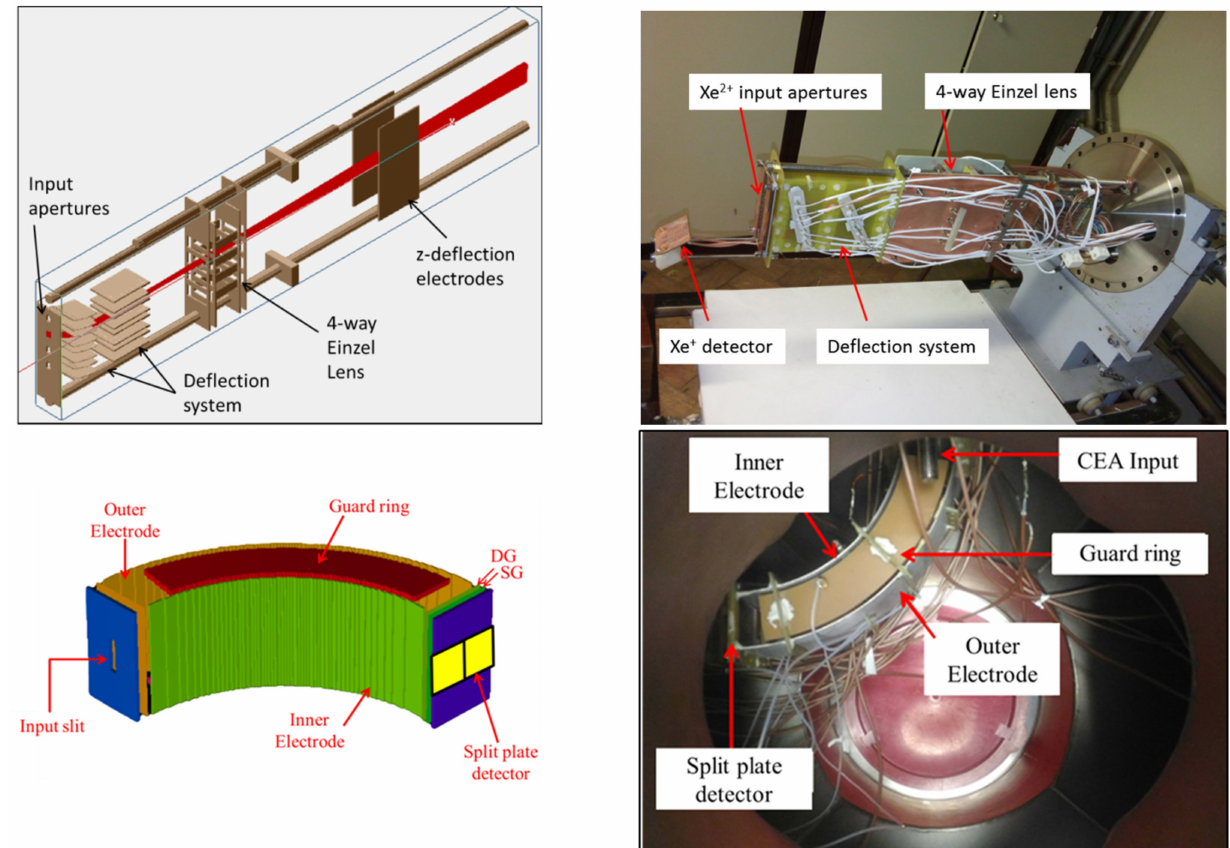
Figure 24. Components of the detection system: Xe 2+ deflection system with Einzel lens ( top row ) and cylindrical energy analyzer ( bottom row